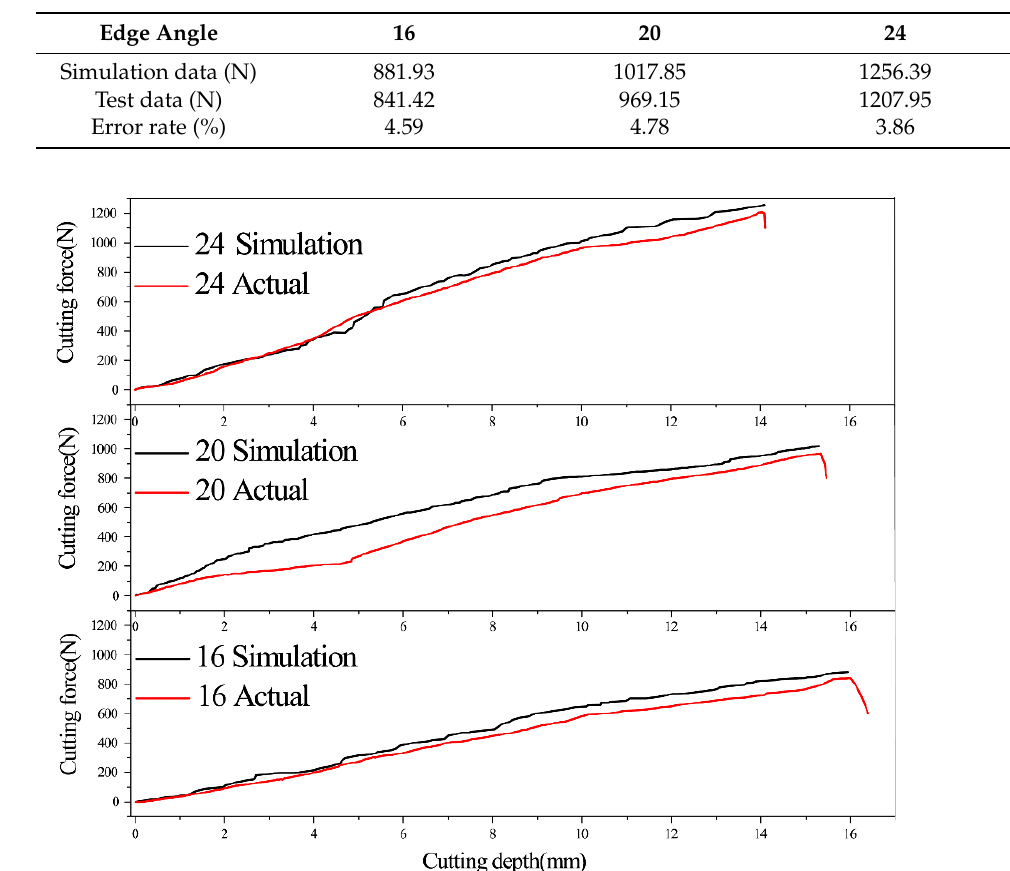
Figure 4. Simulation and actual comparison of cutting with different edge